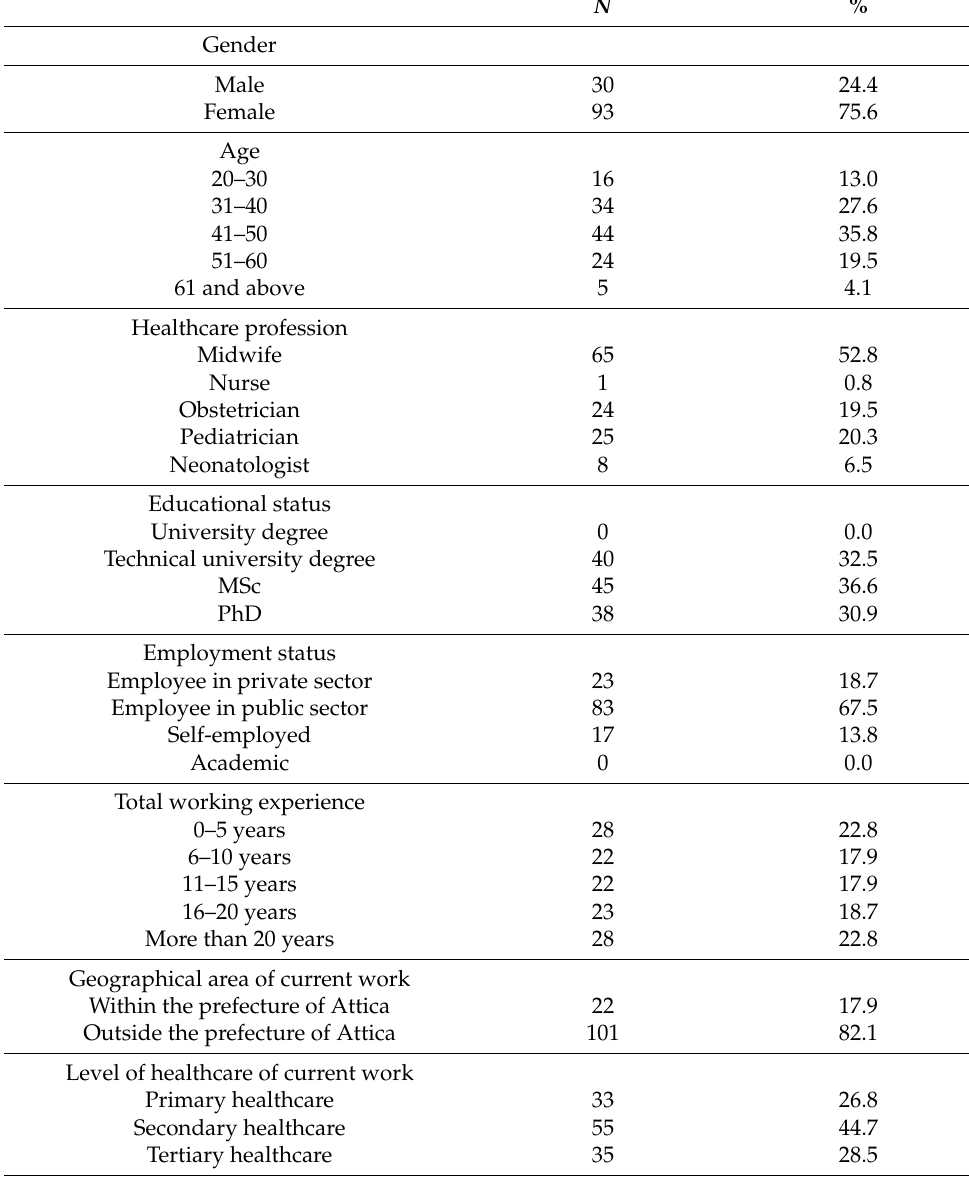
Table 1. Participants’ demographic and occupational